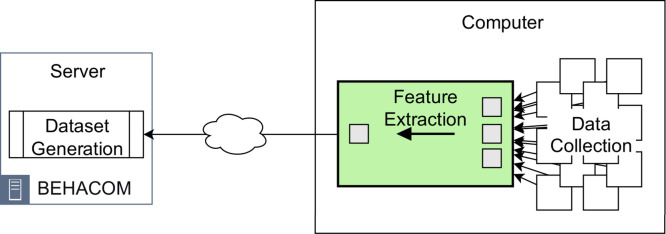
Architecture design.